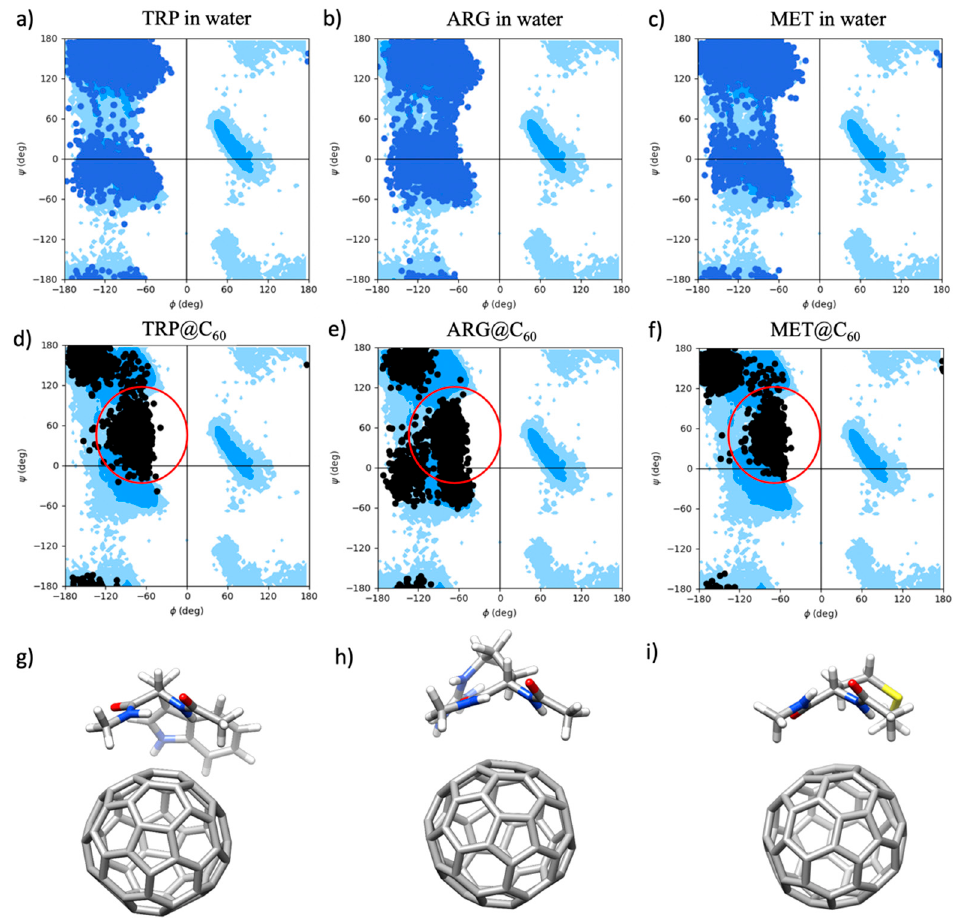
Figure 7. The distribution of the backbone torsional angles ( a – f ) obtained for Trp, Arg, and Met in ( a – c ) bulk water and ( d – f ) upon C 60 binding. The background regions (shown in cyan) represent the sterically allowed Ramachandran angles. Blue ( a – c ) and black ( d – f ) points represent the torsional angles phi ( φ ) and psi ( ψ ) of the amino acids observed during the MD simulations. ( g – i ) Representative structures of the “tepee-like” conformations of Trp@C 60 ( g ), Arg@C 60 ( h ), and Met@C 60 ( i ).